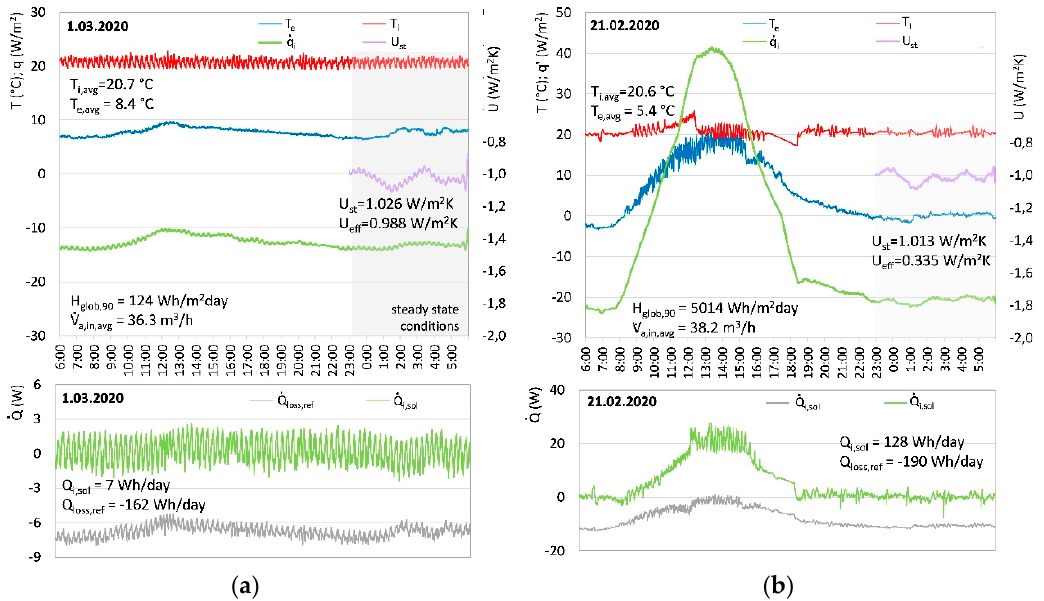
Figure 7. An example of measured values used for the evaluation of the energy efficiency of dynamic thermal insulation of the BIPV glazed façade structure. ( a ) In the case of heavy cloudy day (1 st March 2020), because the air gap was ventilated, U st was equal to reference thermal transmittance of composite façade structure ( U ref 1.027 W/m 2 K) and U eff was very close to the U st ; ( b ) even in the case of clear sky weather (21 st February 2020), the U st was very close to the reference value, while dynamic thermal transmittance was much lower, indicating a significant difference in diurnal transmission heat loss Q i,sol from the pilot BIPV glazed façade structure.